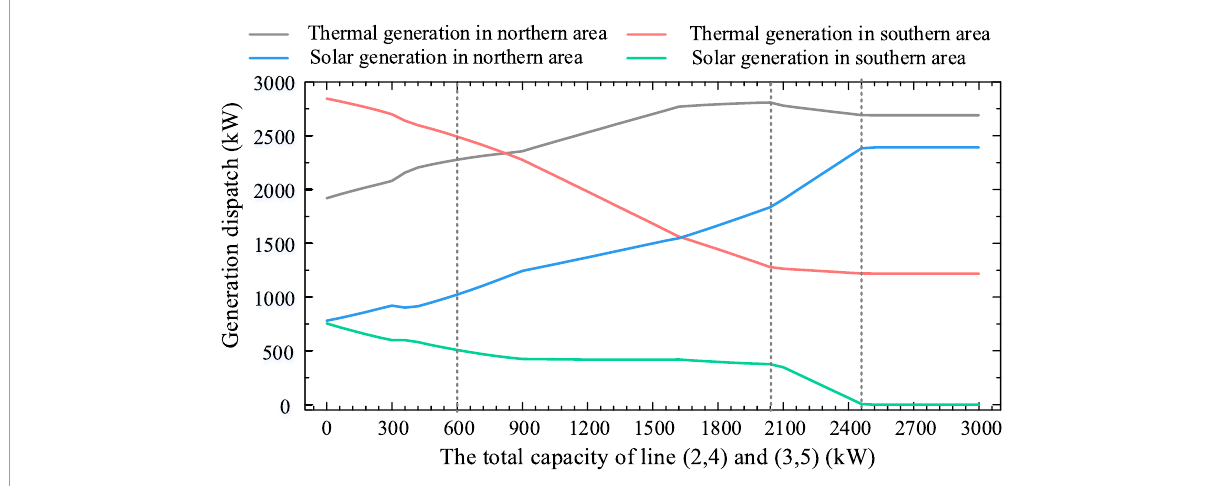
FIGURE 5 Total dispatch of thermal and solar generators for different values of the total capacity of lines (2.4) and (3.5).